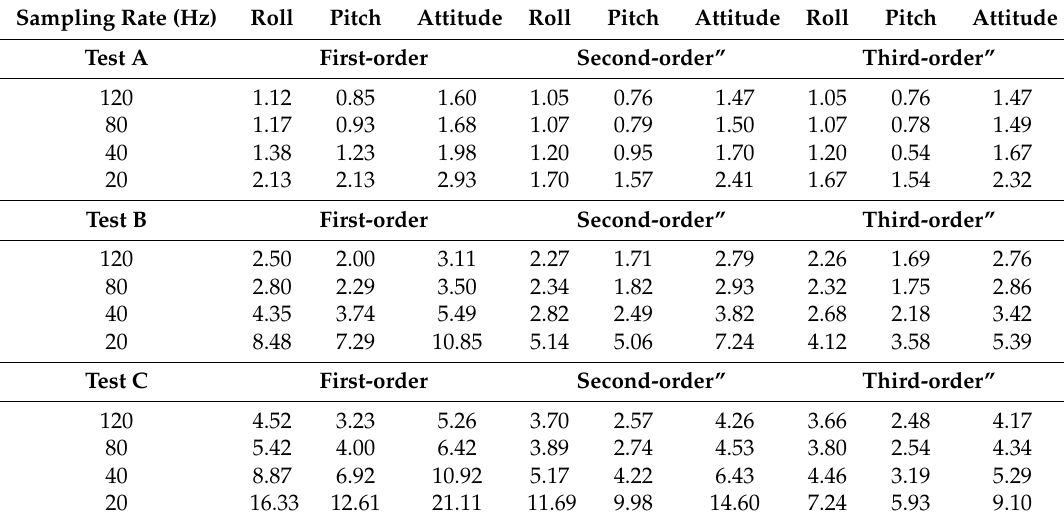
Table 2. Averaged RMSE results for Case 2 (unit: ◦ ).